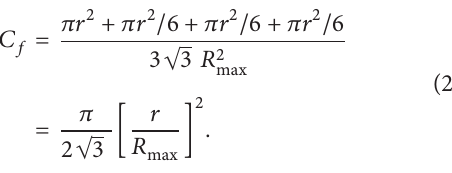
represented by the radius of the incircle of equilateral